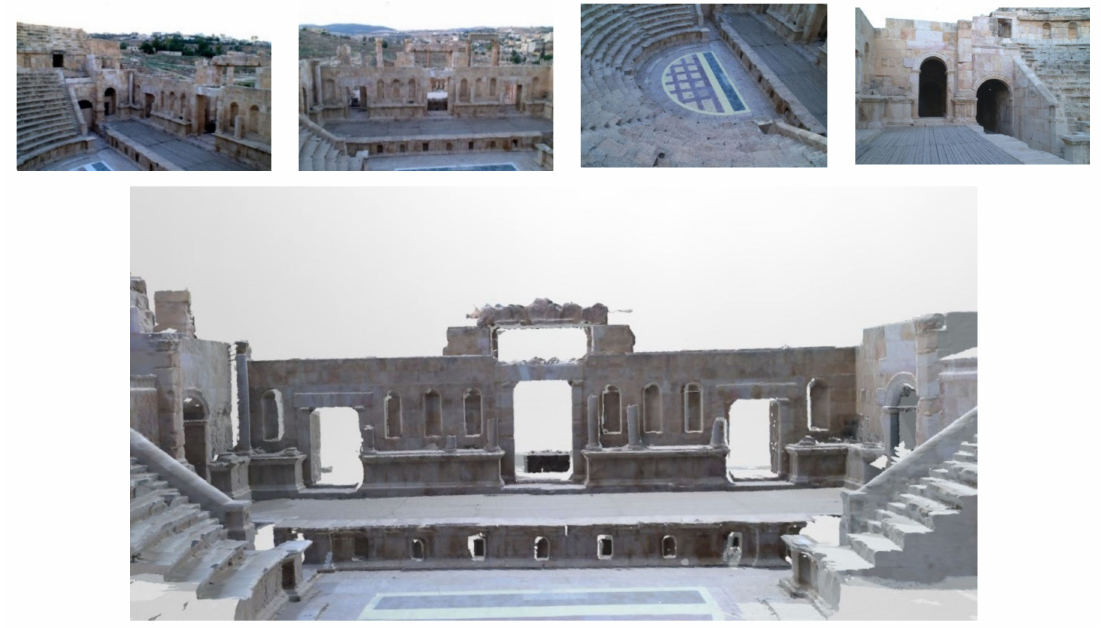
Figure 21. Texture mapping of Northern Theatre using multiple